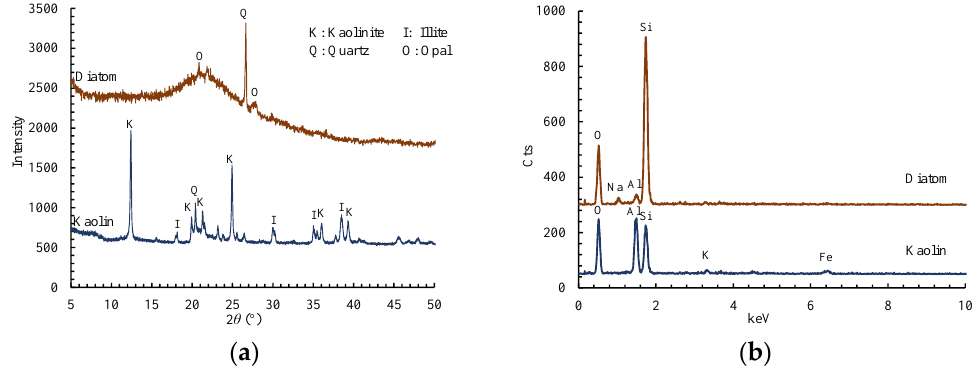
Figure 1. Mineral and chemical compositions of diatoms and kaolin as determined by ( a ) X-ray diffraction and ( b ) X-ray energy-dispersive spectroscopy. Table 1. Physical properties of pure diatom and kaolin. Value Parameter